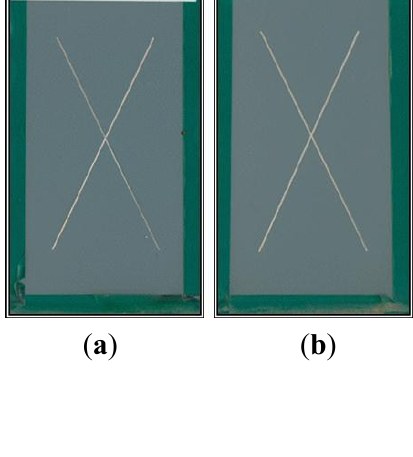
Figure 4. Photos after 24 months of outdoor exposure testing. ( a ) control; ( b )